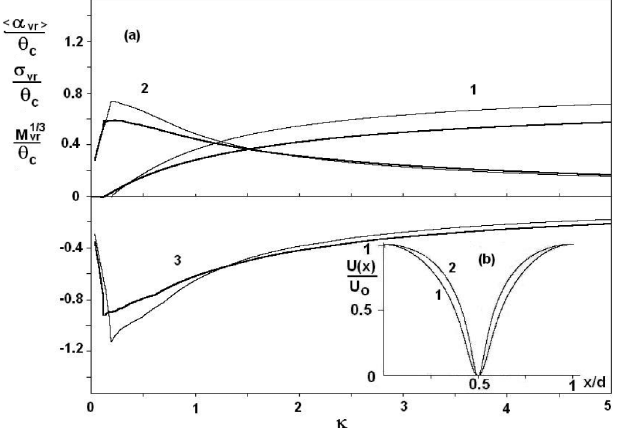
FIG. 11. The main characteristics of volume reflection for negative particles. (a) Values h (cid:5) as functions of the generalized parameter (cid:12) for (110) planes of silicon and tungsten single crystals (the thin and thick curves 1, 2, and 3, correspondingly); (b) normalized potentials U (cid:1) x (cid:2) =U the (110) plane in silicon (1) and tungsten (2) as functions of the relative coordinate.